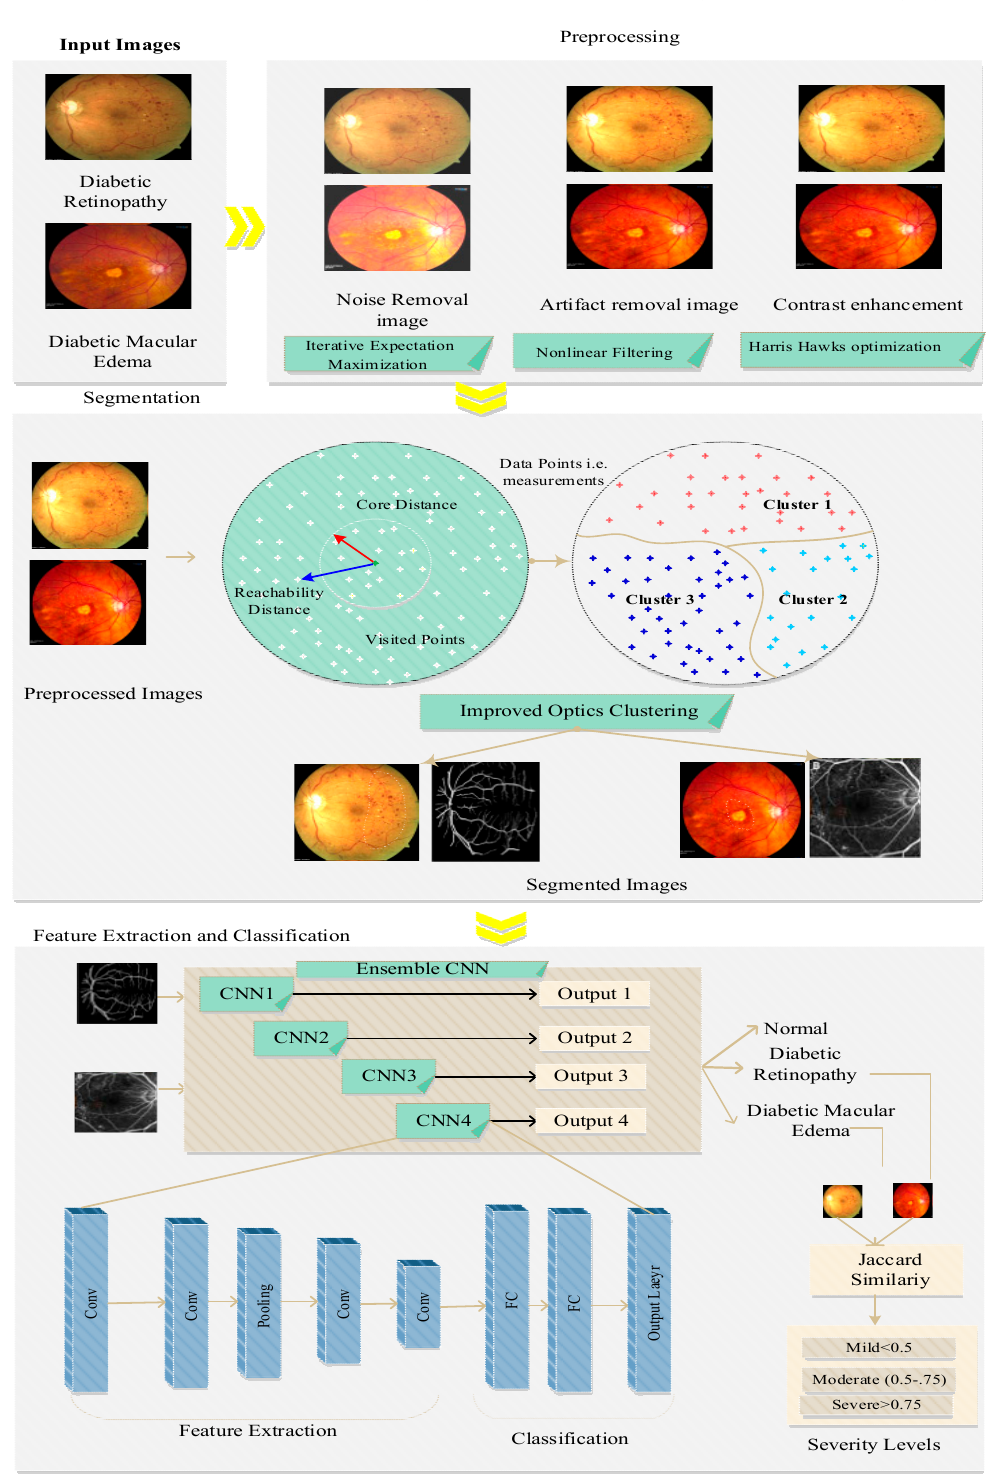
Figure 2. System